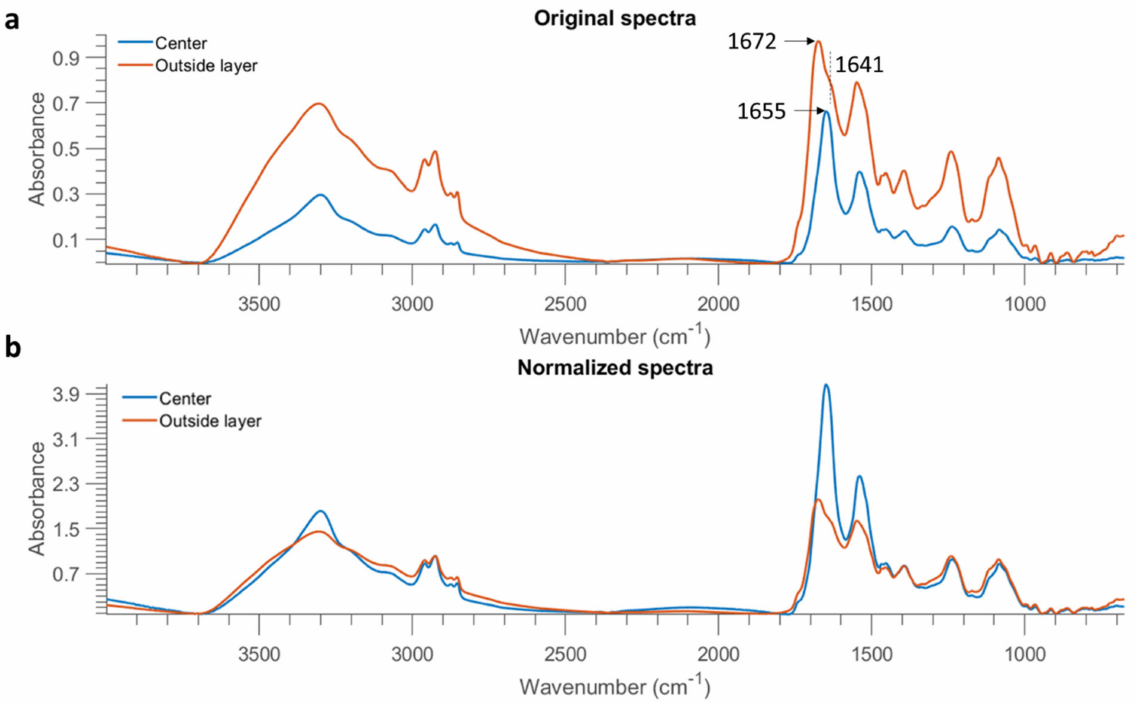
Figure 8. Mean spectra of the centre part and outside layer of one E. coli sample at 10 OD from STS (after removing baseline using asymmetric least squares smoothing) ( a ), as well as the result after normalization by dividing the intensity at 2926 cm − 1 ( b